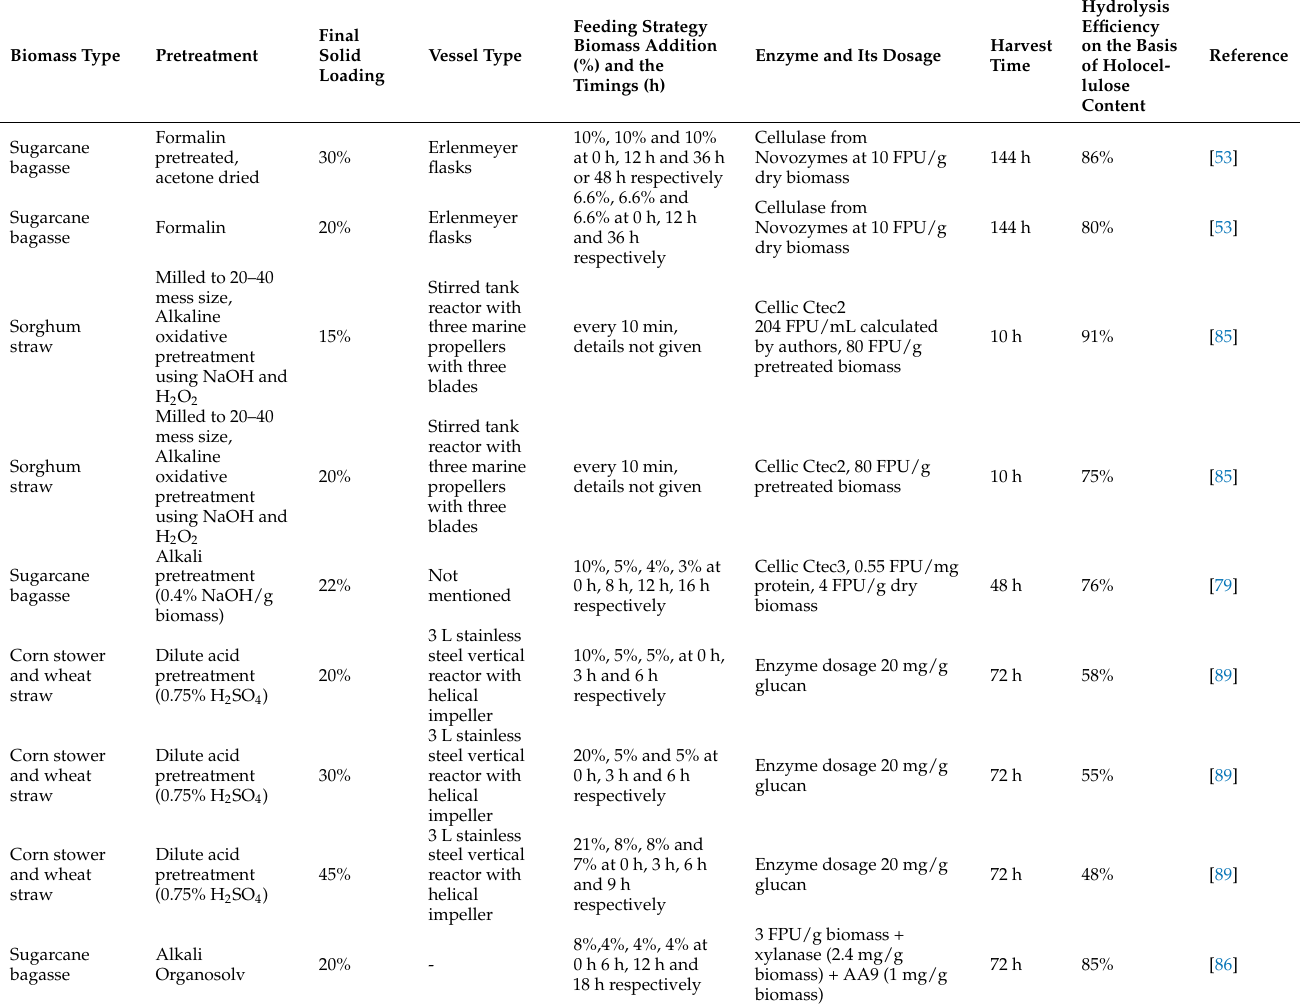
Table 3. High solid loading of biomass adopting fed-batch mode for increased sugar